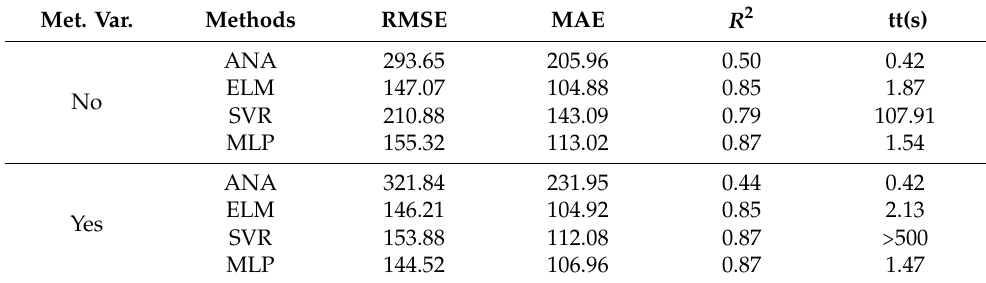
Table 8. Performance of the evaluated ML methods in the prediction problem over San Sebastian parking occupancy dataset.